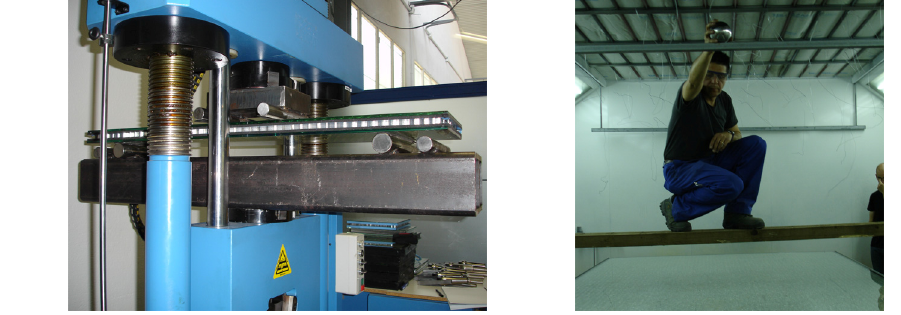
Figure 8: Bending strength test. Figure 9: Hard-body impact test included in the CWCT-42 test